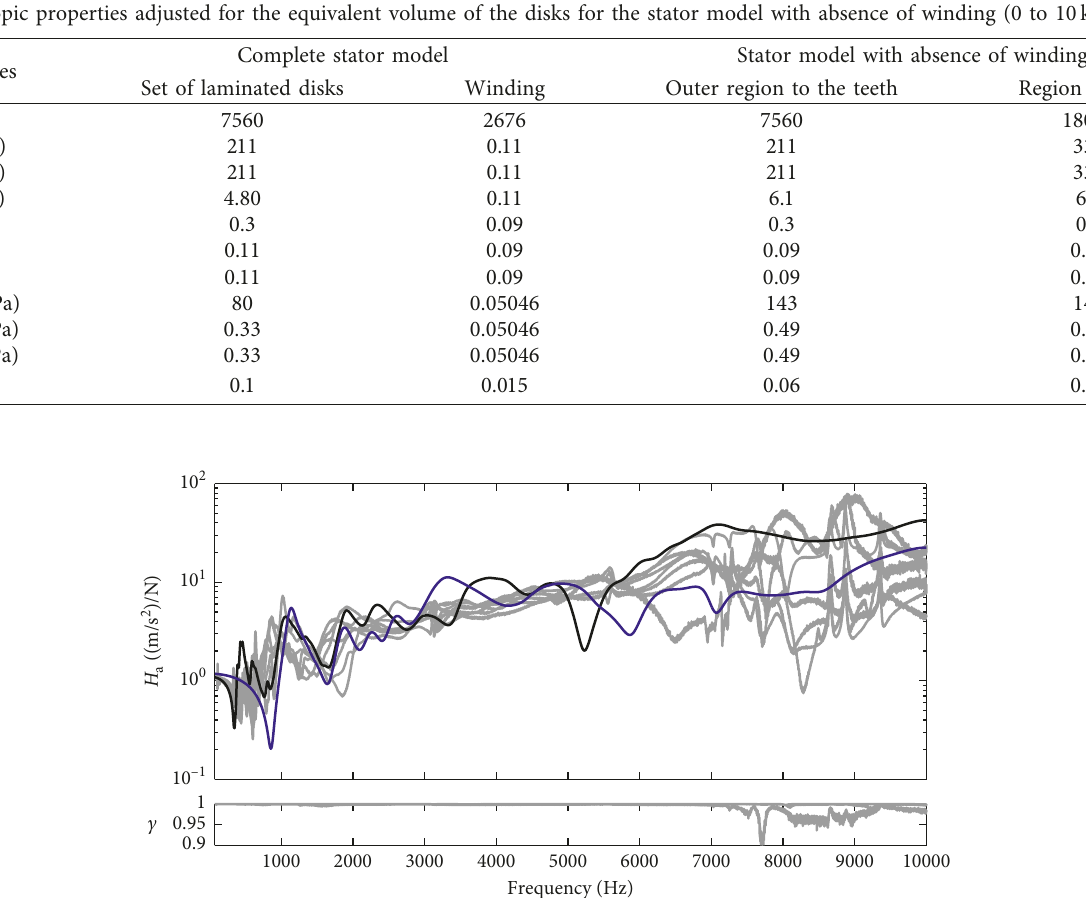
Figure 18: Comparison between the numerical (lines in black and blue) and experimental (lines in gray) FRF values for transversal excitation ( z direction) and response measurement at point E1 ( z